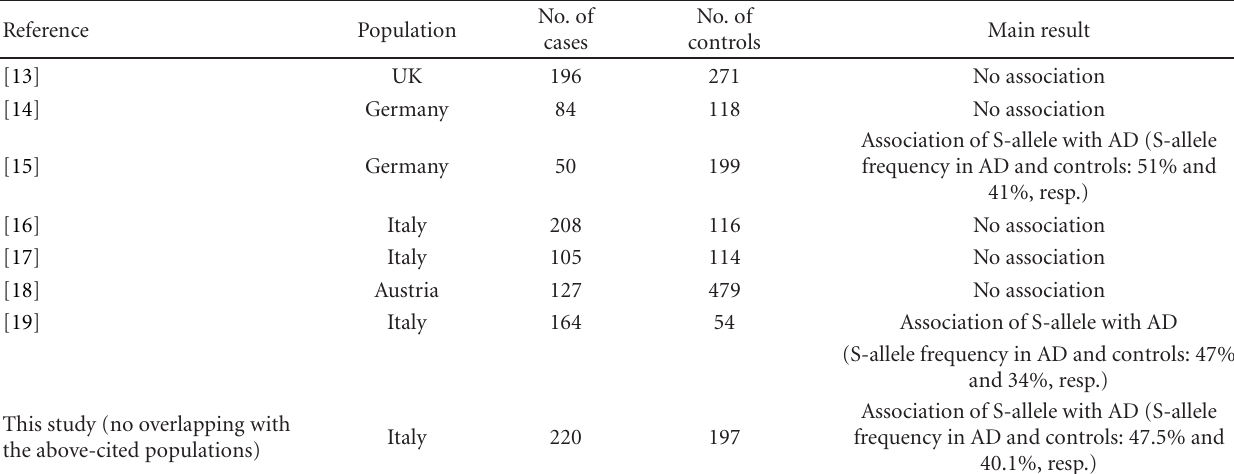
Table 1: Literature overview of the 5-HTTLPR polymorphism in association with AD in the Caucasian population.